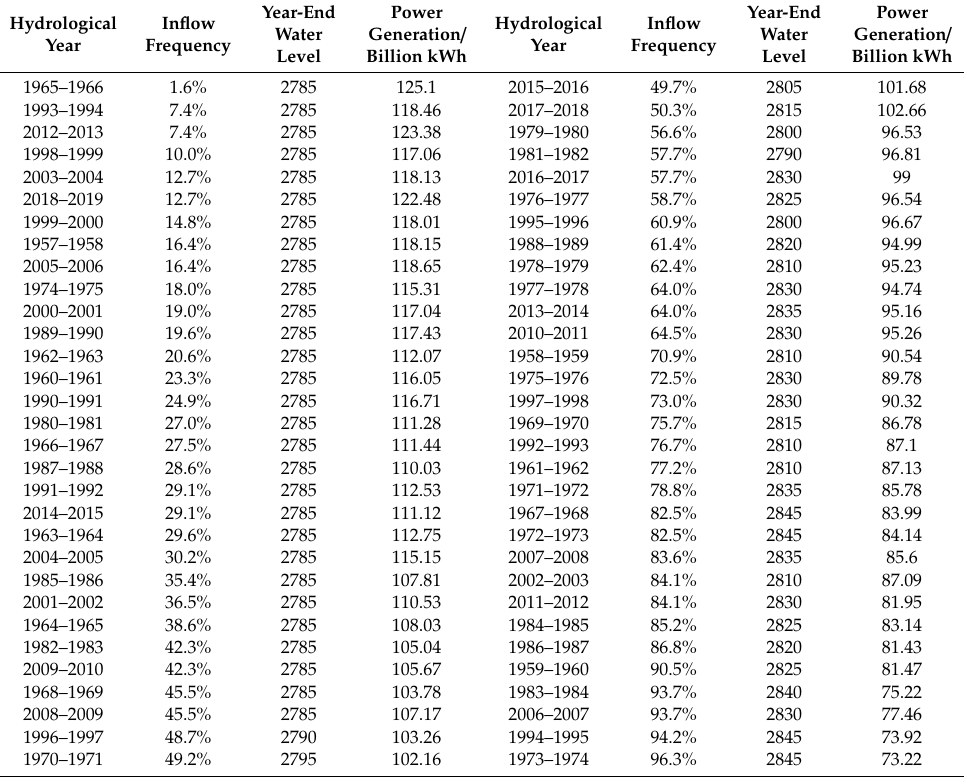
Table 9. Optimal year-end water levels and corresponding power generation under di ff erent inflow frequencies.